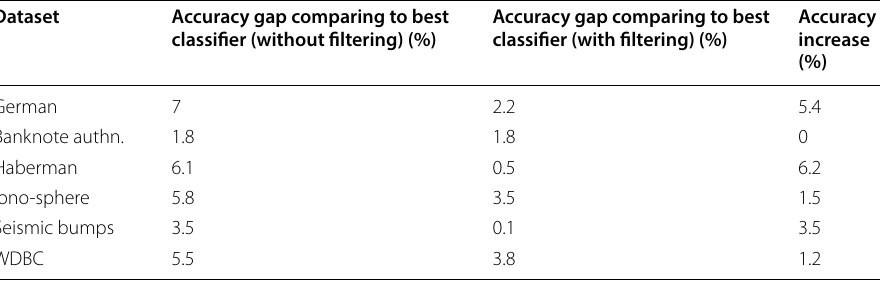
Table 5 Decision tree filtering impact analysis Dataset Accuracy gap comparing to best classifier (without filtering)